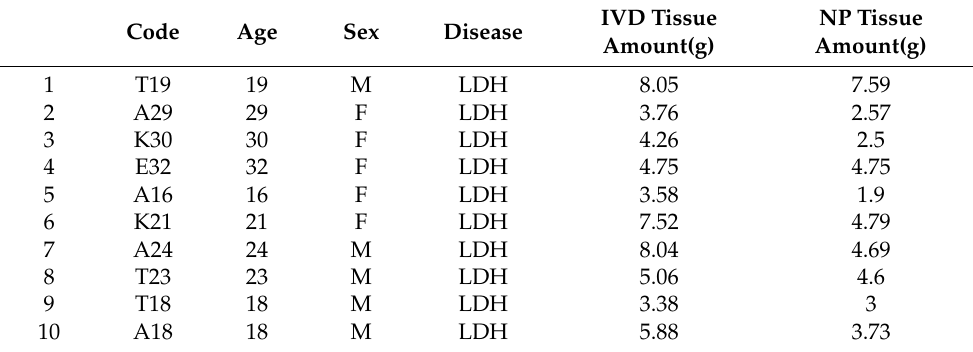
Table 1. Details of clinical samples. Age, sex, total weight of IVD tissue collected at the time of surgery, and weight of NP tissue after selection are listed for each sample. LDH: lumber disc hernia, IVD: intervertebral disc, NP: nucleus